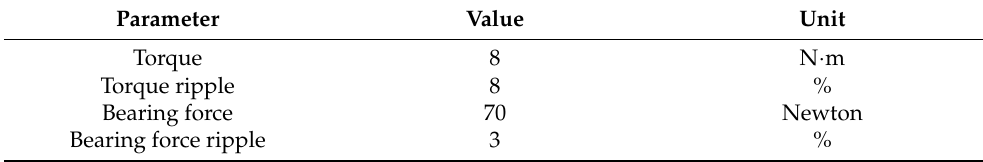
Table 3. Objective function of design.